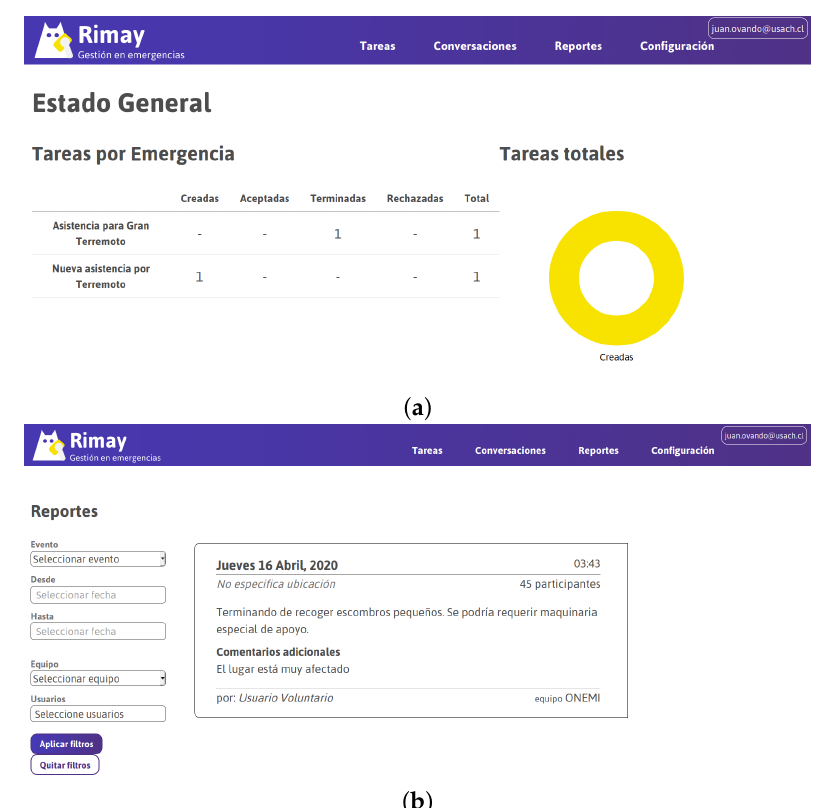
Figure 5. Screenshots of Rimay’s Front-end application: ( a ) login web page, ( b ) information about users.